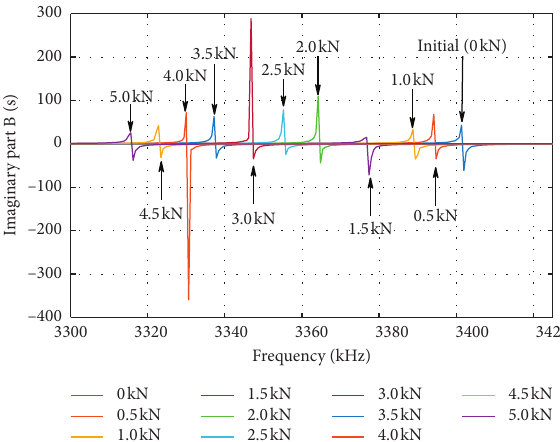
Figure 8: Admittance (imaginary part) signatures at different load conditions between 3300kHz and 3420kHz excitation.